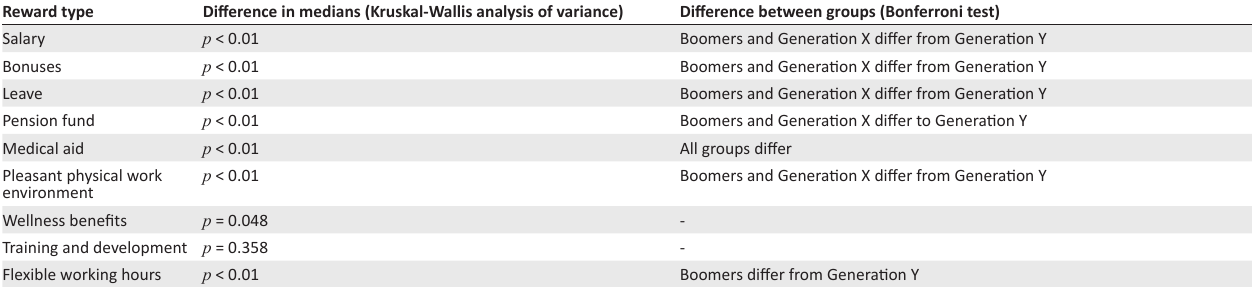
TABLE 10: Comparison between employers of reward package received. Reward type